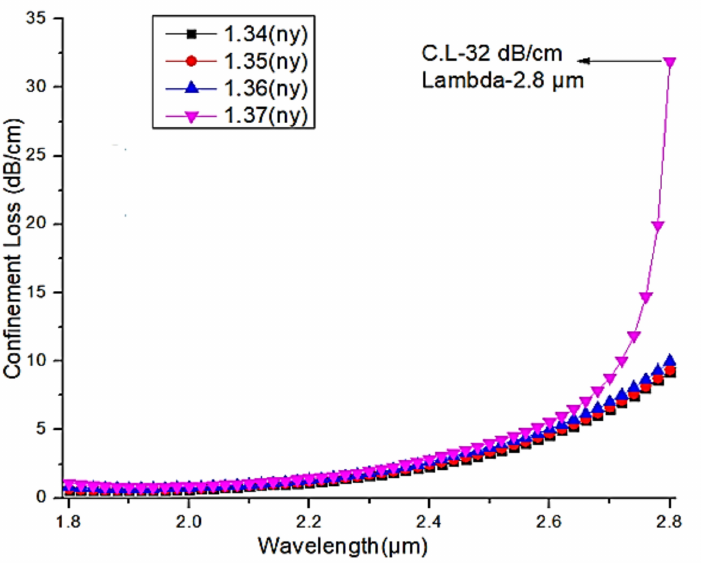
Figure 13. Confinement loss in Y-polarization with respect to wavelength (extracted from Figure 12 for more